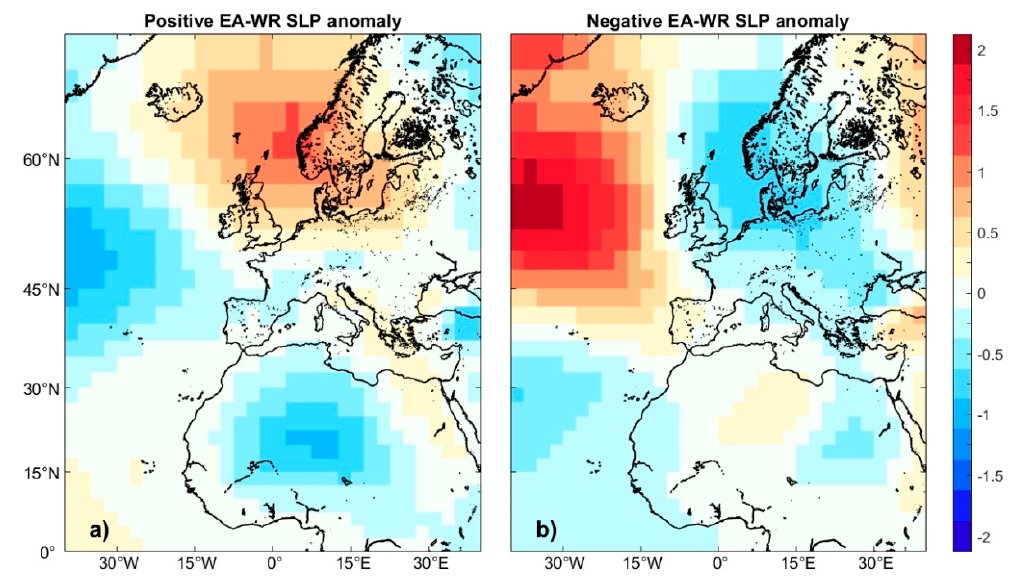
Figure 4. Composites of sea level pressure anomalies (mbar) in the period 1948–2008. Panel ( a ) reflects the positive phase (higher quartile) and panel ( b ) the negative phase (lower quartile) of the EA–WR.